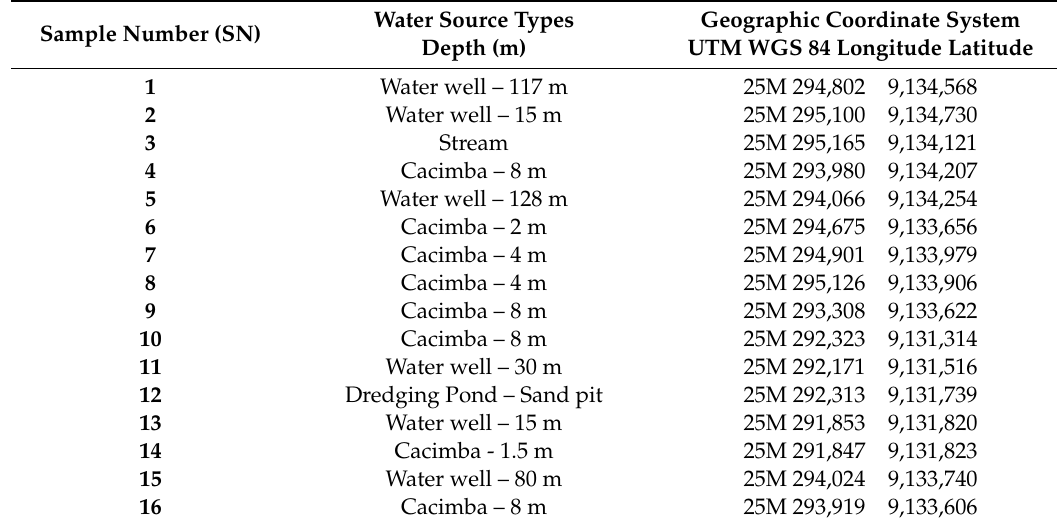
Table 1. Identification (number), source, and geographic coordinates of the water